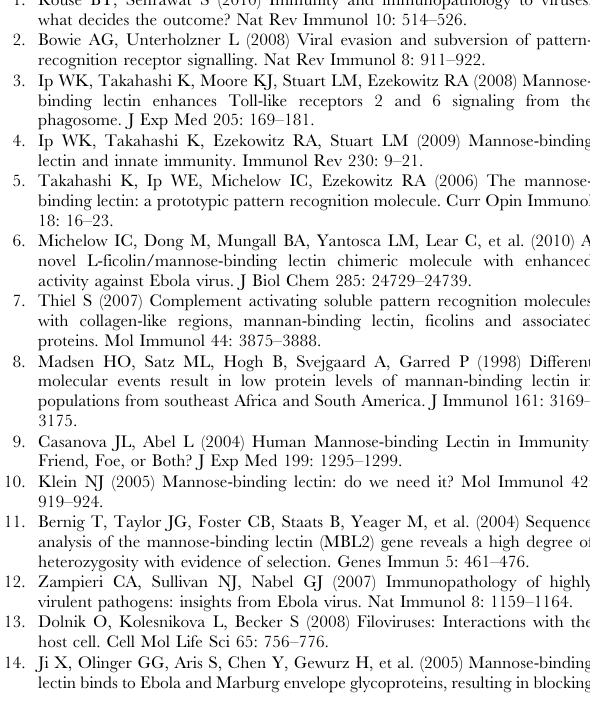
Figure S7 rhMBL targets N -linked glycans on surfaces of wild type-like EBOV and HEK293T cells. (A) We preincubated 5% MBL-deficient serum (with or without MBL supplementation) with media or mannan (1 m g/ml) at 37 u C for 1 hour. Then we incubated wild type-like EBOV-eGFP (1976 Mayinga variant) with the above preparations at 37 u C for 1 hour. Finally, we infected 4 6 10 4 HEK293T cells with virions at a multiplicity of infection of 0.1. (B) We preincubated (i) HEK293T cells with varying concentrations of tunicamycin and (ii) wild type- like EBOV-eGFP with 5% MBL-deficient serum (with or without rhMBL supplementation) at 37 u C for 1 hour. Then we infected 4 6 10 4 HEK293T cells with virus at a multiplicity of infection of 0.1. Fluorescence was assayed 72 hours after infection. Significant differences are shown. Experiments were performed in triplicate. Table S1 List of human genes included in RNA inter- ference (RNAi) screen. Table S2 Primers for qRT-PCR assays. Methods S1 Supplementary